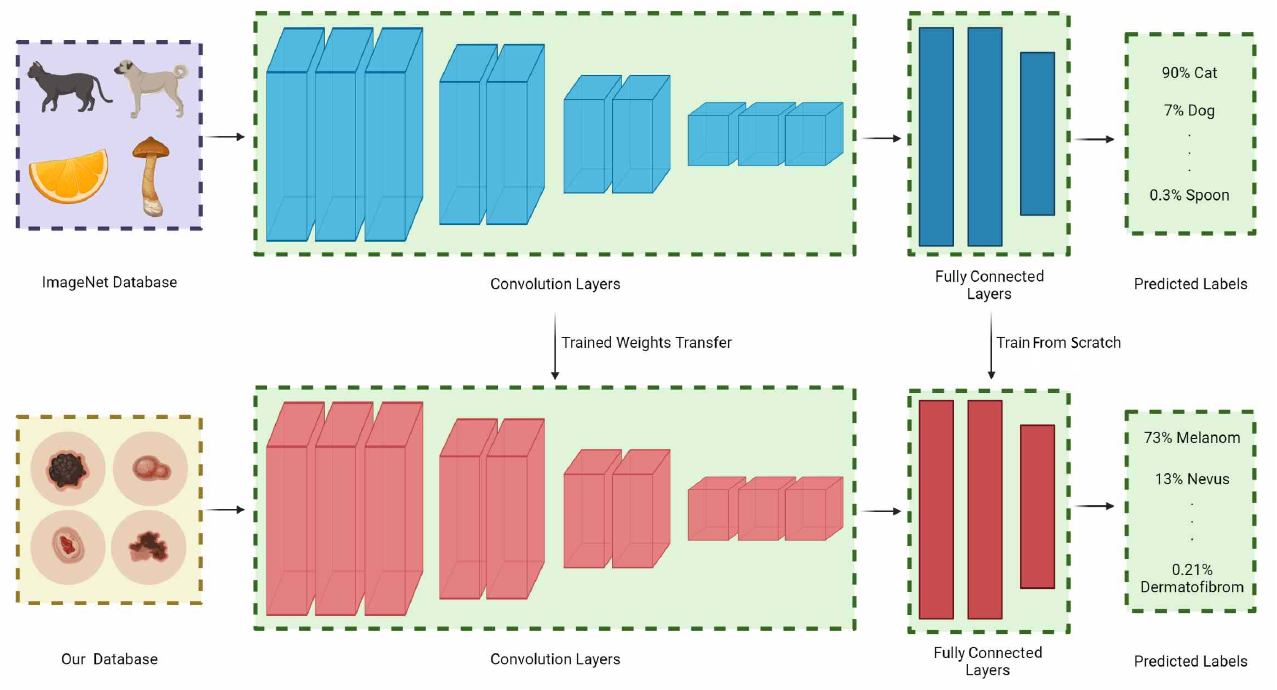
Figure 4. Overview of transfer learning process. The weights obtained on the ImageNet dataset are transferred to the convolution layers. The weights in the fully connected part are retrained. After optimization, the four deep learning models have two 128 node dense layers and one dropout layer with a 0.2 ratio as fully connected